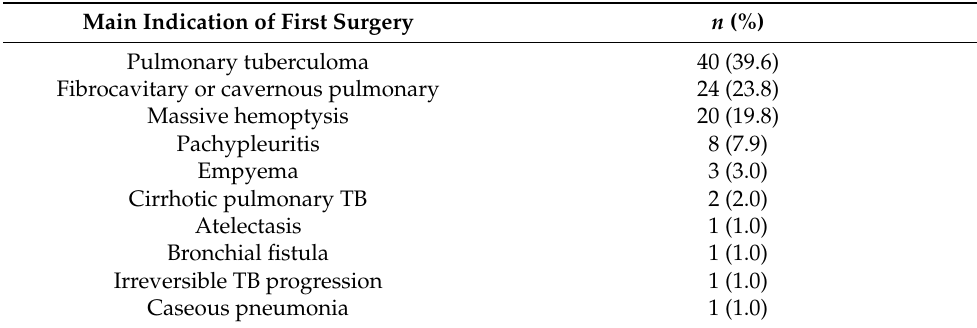
Table 2. Main indications for the first surgical procedures in patients with respiratory tuberculosis who underwent adjunctive surgery at RSSPMCPP in Uzbekistan from January to May 2017 ( n = 101). Main Indication of First